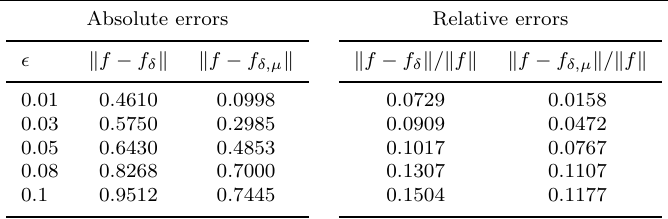
Table 1. Example 1: Errors assuming α 2 = 2 . 10 − 5 , β = 1 . 10 − 5 ,ν = 1 ,t 0 = 1 ,p = 1. Absolute errors Relative errors